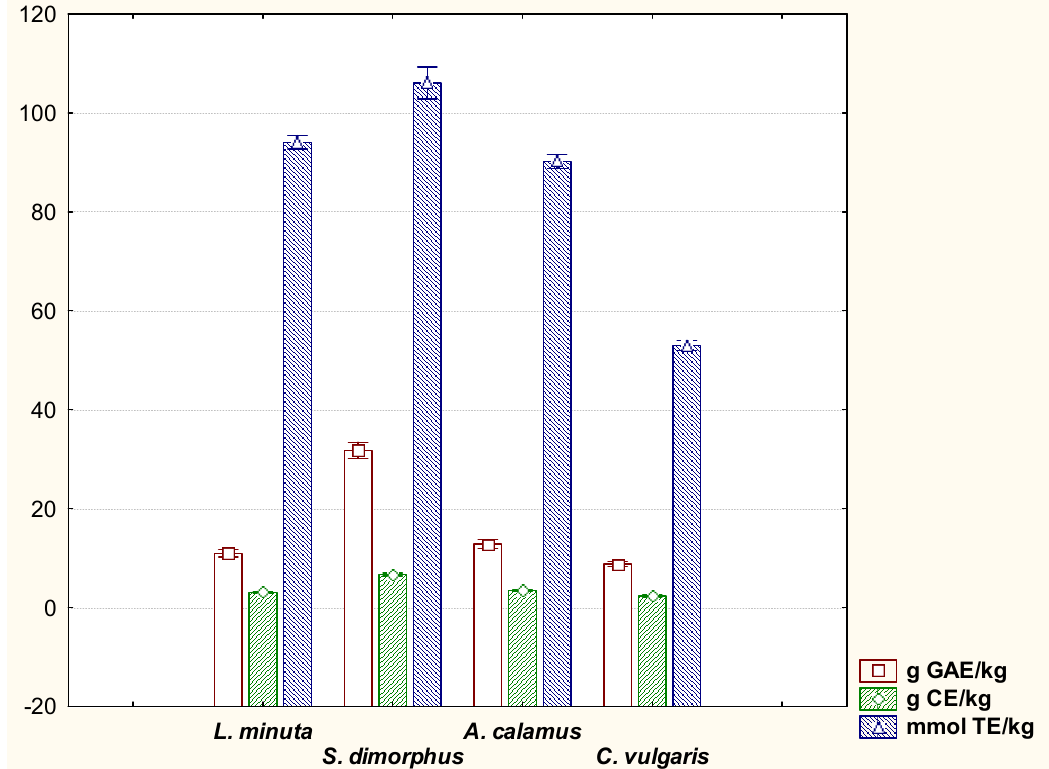
Figure 1. Total phenolic content (g GAE/kg), total flavonoid content (g CE/kg) and radical scavenging potential (mmol TE/kg) of methanolic extracts from different plants.